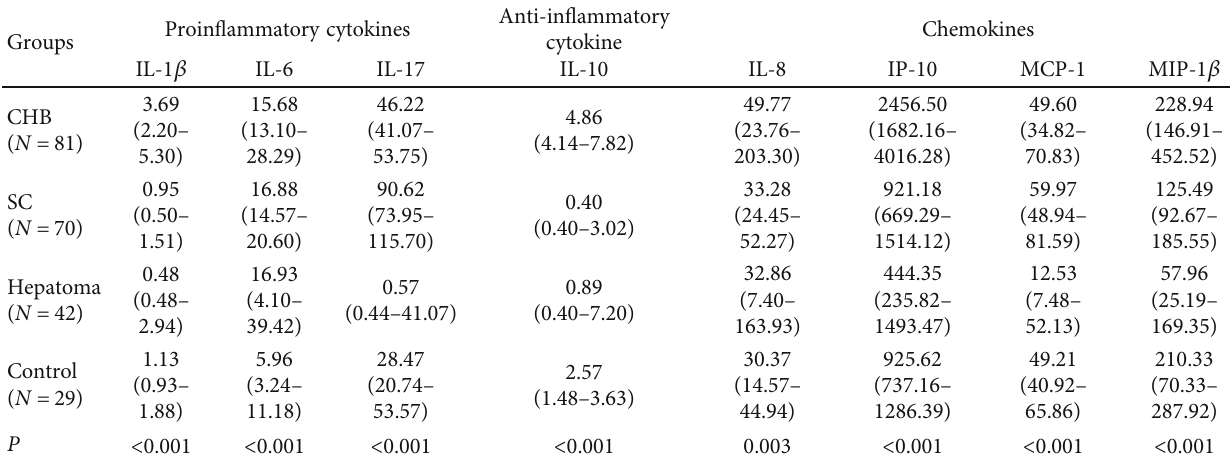
Table 2: Circulating cytokine and chemokine levels of the study